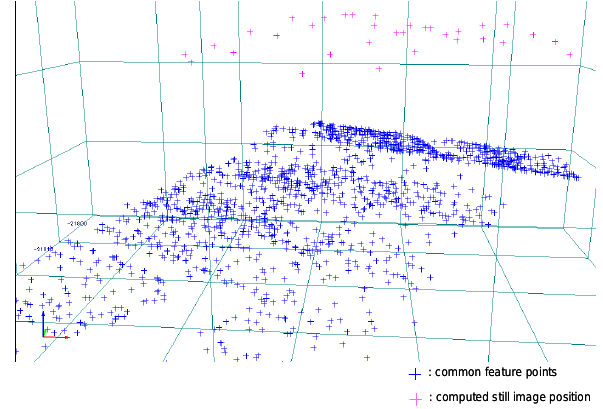
Figure 11. Result of Second Flight